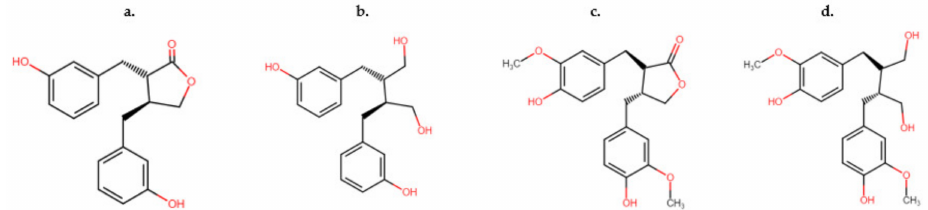
Figure 3. Comparison of the two distinct types of lignans absorbed by ruminants and non-ruminants ( c ) matairesinol, ( d ) secoisolariciresinol, and their metabolites ( a ) enterodiol and ( b ) enterolactone.